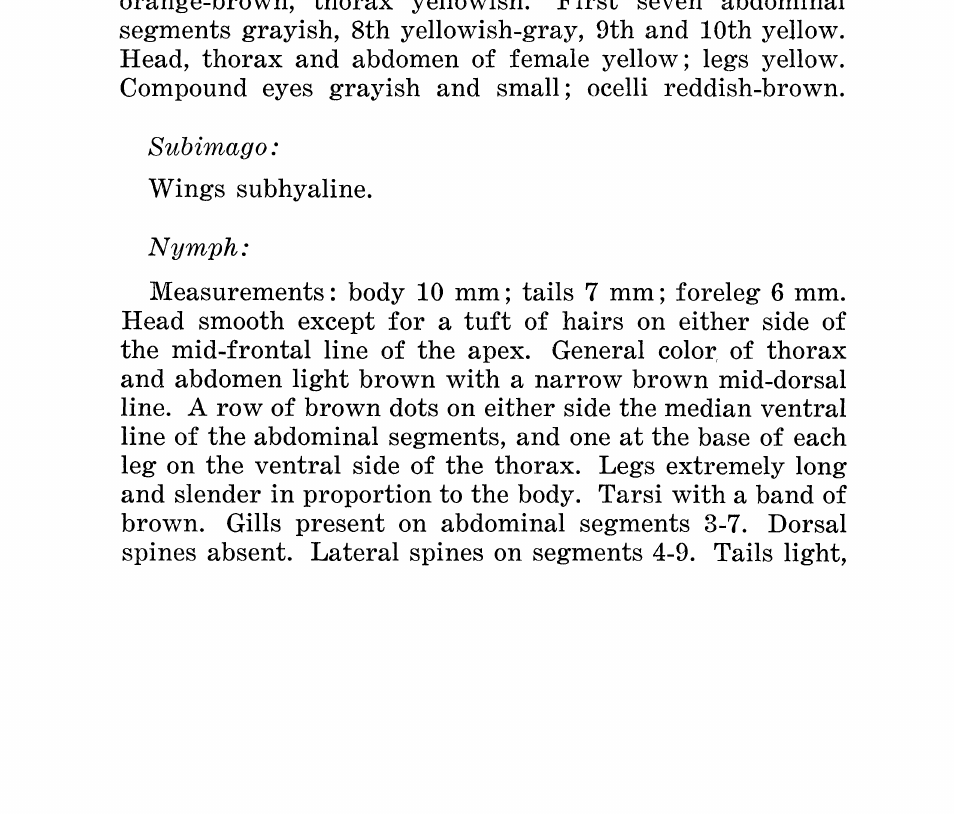
(Measurements of emale Compound eyes of the male First seven abdominal